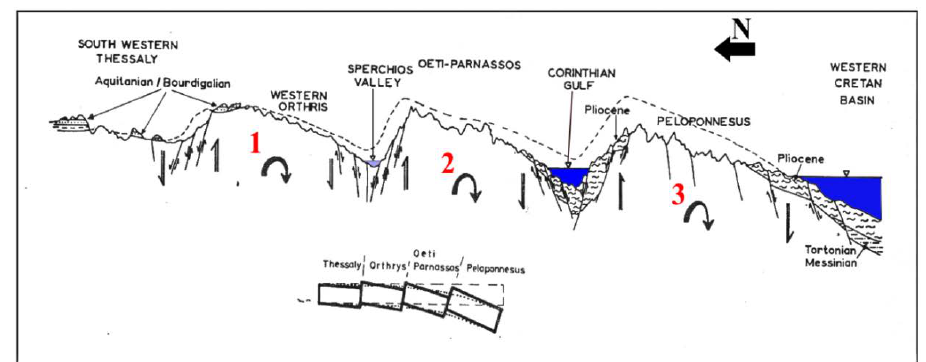
Figure 2. The tectonic activity of the area based on the tectonic dipole’s theory (Mariolakos, 1976), red numbers 1, 2 and 3 showing the three parts of the tectonic dipole’s theory (also appearing in Figures 1a and 3).